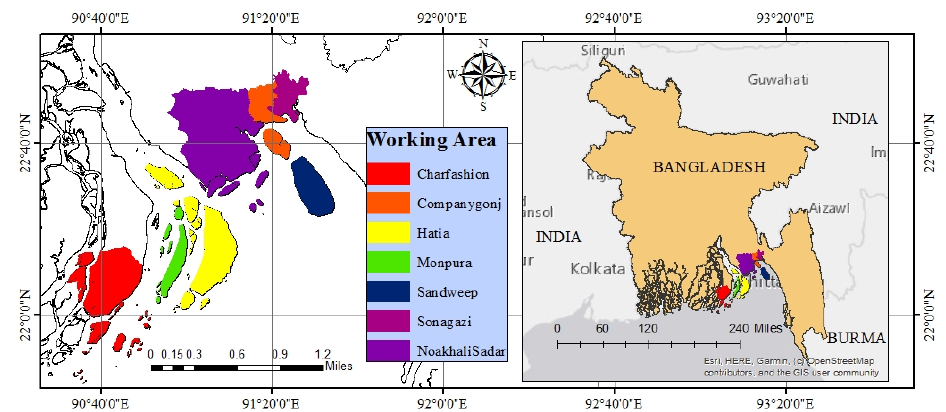
Figure 2. The coastal area of Bangladesh for microscale analysis.